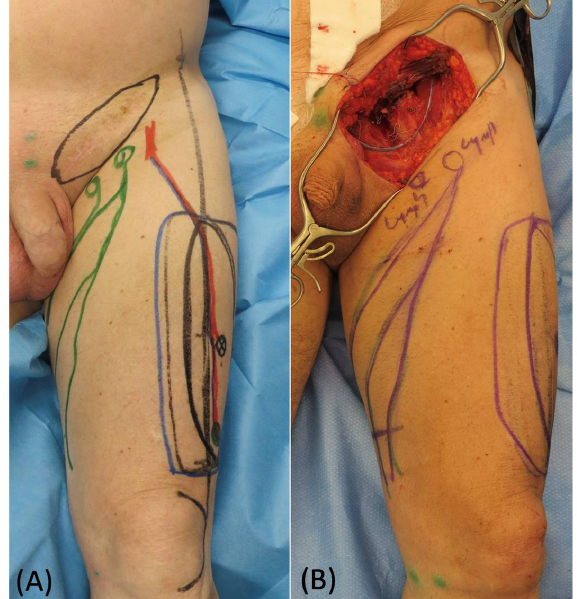
Figure 4. ( A ) Preoperative picture of skin marking of the ALT flap with ICG-guided lymphatic ducts detection. ( B ) Remaining groin defect after sarcoma removal.